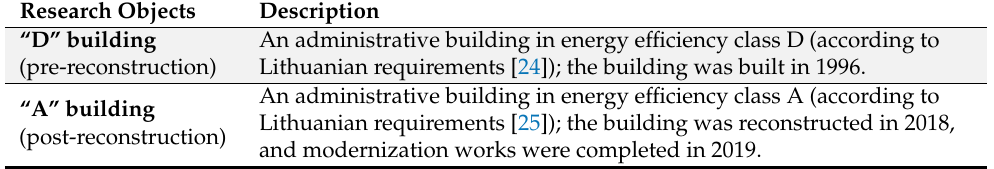
Table 2. Objects of